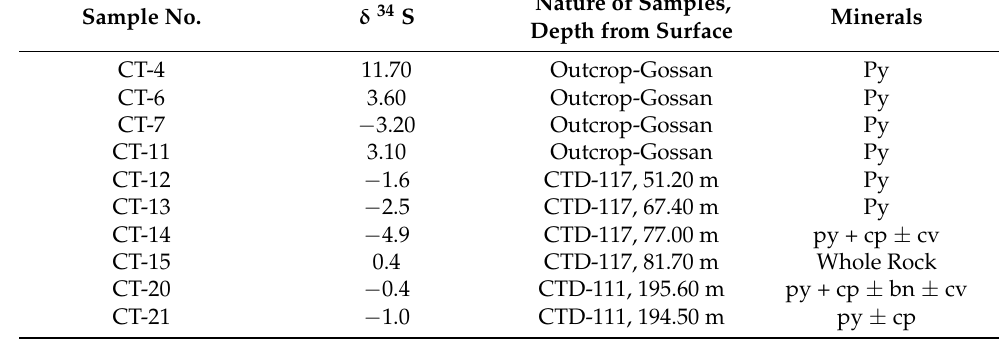
Table 3. δ 34 S isotope data of samples from gossan and massive ore zone of Cerattepe VMSD. Each color represents different drill core and gossan samples. Sample No.